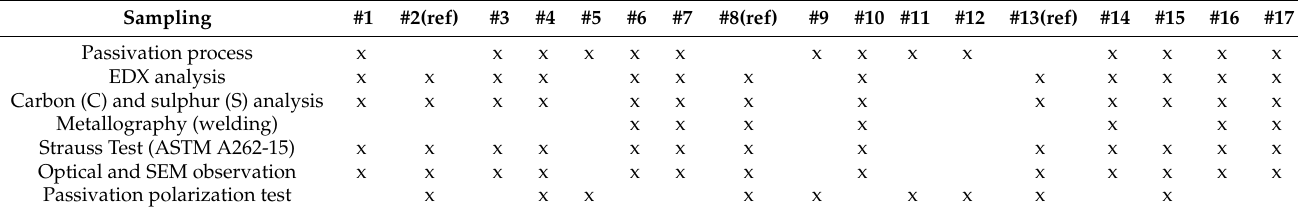
Table 2. Examination plan of the evaluated hypotubes. EDX: energy-dispersive X-ray spectroscopy.